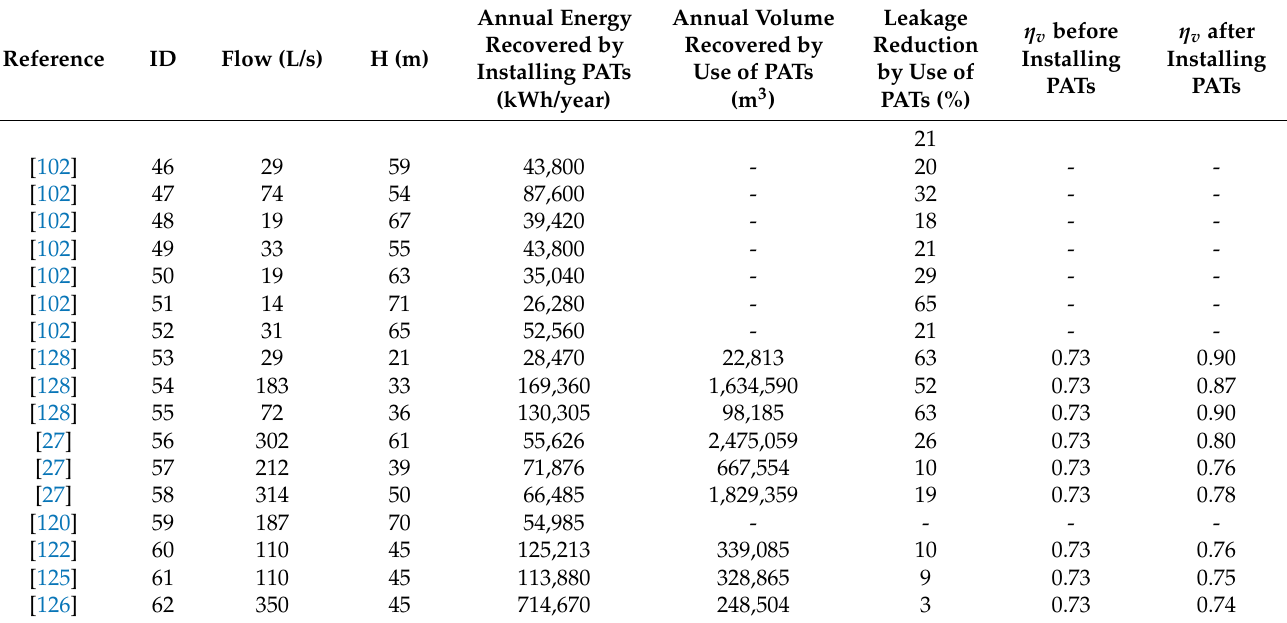
Table 9. Information extracted from case